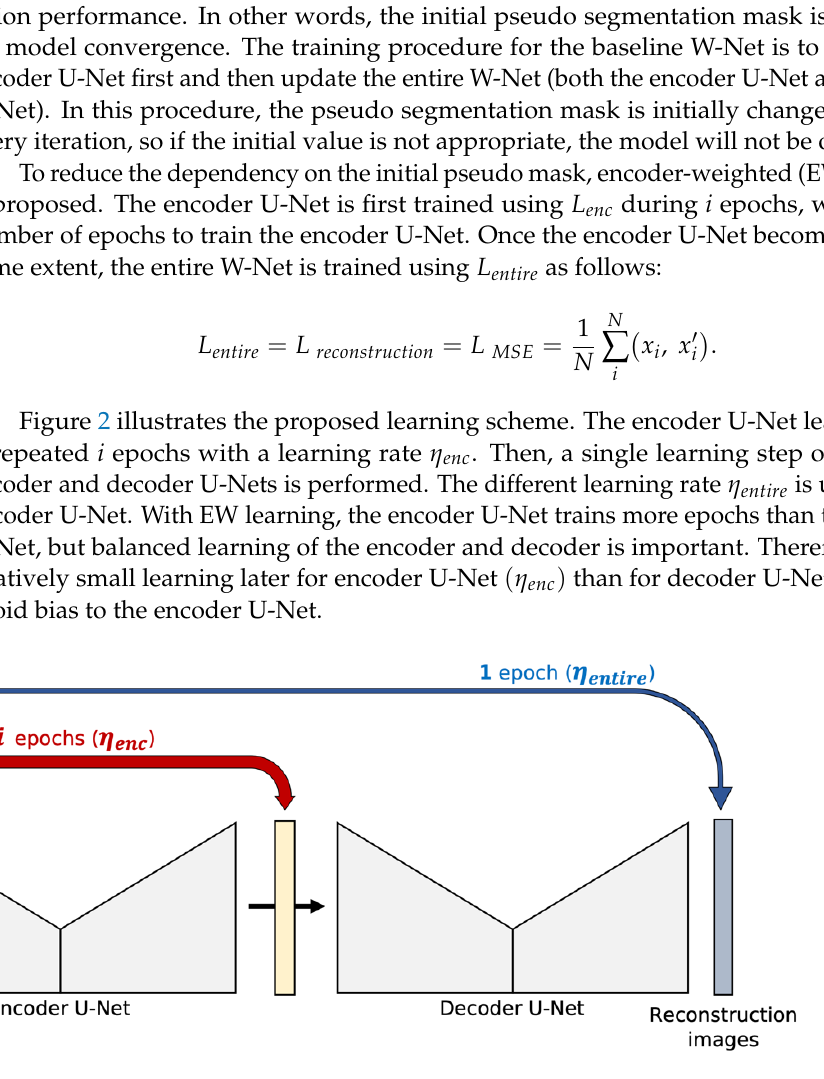
Figure 2. Proposed encoder-weighted learning scheme.